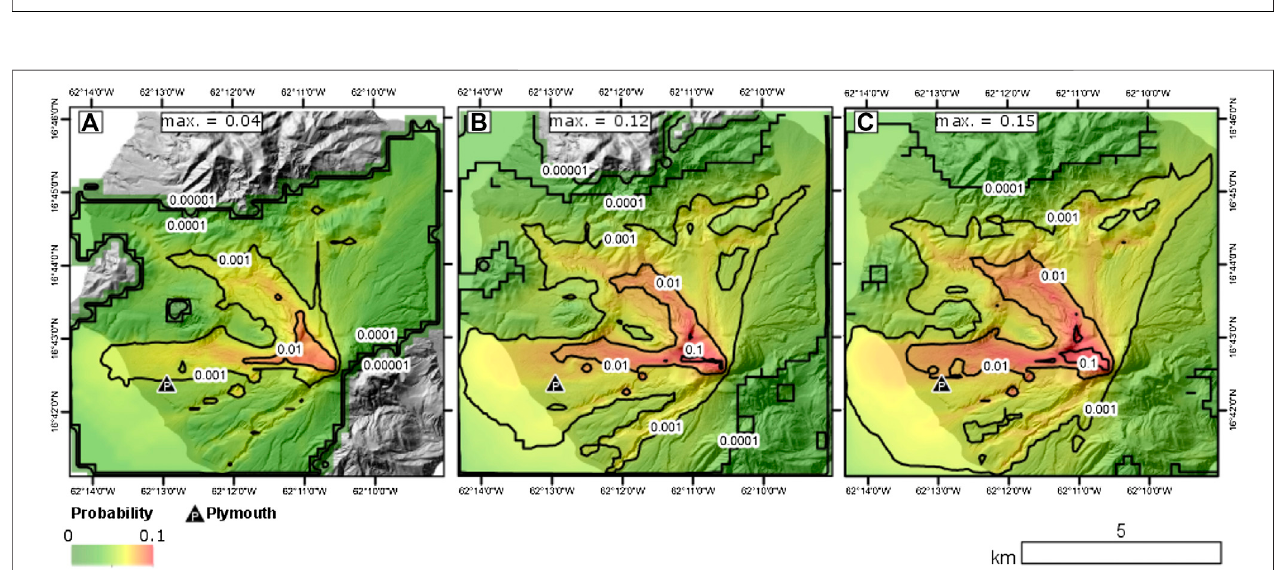
FIGURE 7 | Probability of PDC inundation forecasts plotted on a log 10 color scale, under the assumption of a distribution for p ( ϕ ) that is a point mass at ϕ (cid:2) 0 + , i.e., due east via the Tar River Valley to the sea. Inundation probability contours are plotted for visual reference. Panel (A) is a forecast for s (cid:2) 1 year, (B) for s (cid:2) 5 years, and (C) for s (cid:2) 20 years into the future.